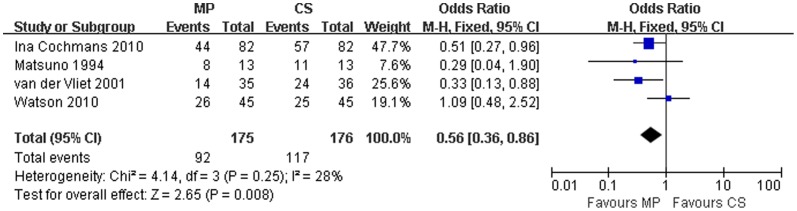
DGF rates for DCD kidneys preserved by MP versus CS.Pooled estimate of odds ratio (OR) and 95% confidence intervals (CIs) of DGF rates for DCD kidneys preserved by MP on 5 studies. Squares indicate OR in each study. The square size is proportional to the weight of the corresponding study; the length of horizontal lines represents the 95% CI. The rhombus indicates the pooled OR and 95% CI (fixed-effect model).